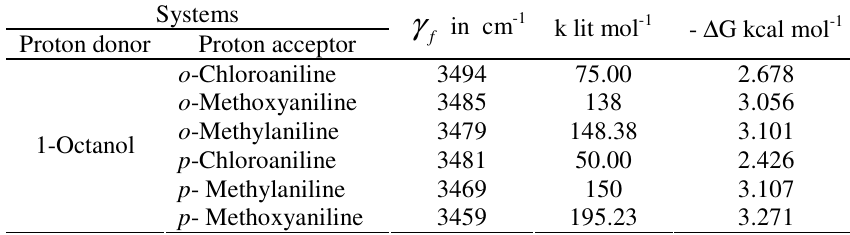
Table 1. Spectral data, formation constant and fee energy change of 1-octanol with ortho and para substitution of aniline in CCl